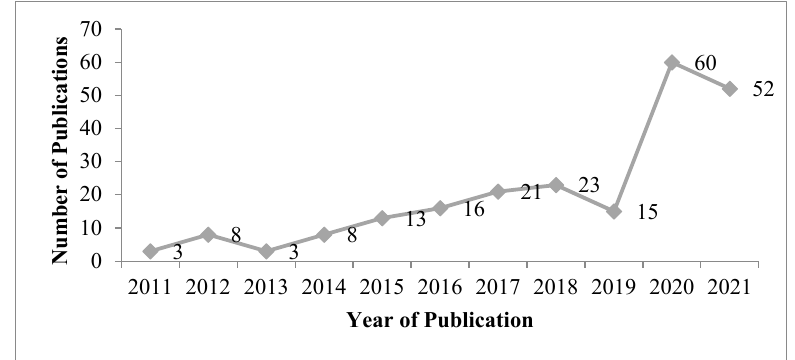
Figure 2. Number of publications over time.